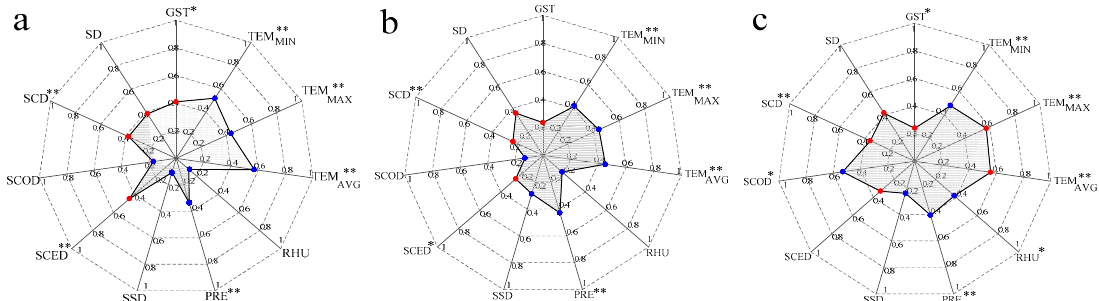
Figure 7. The correlation between SOS and climate factors for three vegetation types: ( a ) meadow steppe; ( b ) typical steppe; and ( c ) desert steppe. Each dot represents the correlation between SOS and the corresponding climate factor, with the red color indicating a positive correlation and blue color indicating a negative correlation. The asterisks (*) indicate the trends of the climate factors trends that are statistically significant with p < 0.1 and the double asterisks (**) indicate trends with p < 0.05.